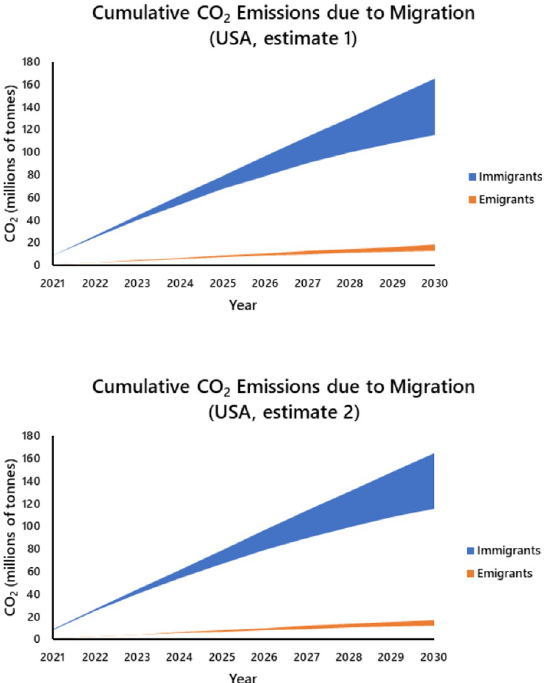
Fig 5. Projected annual cumulative CO 2 emissions associated with migration to and from the USA for the period 2021 to 2030. The upper limit of each curve assumes that the USA maintains 2005 emission levels, the lower limit assumes an annual reduction of 3% (= 30% reduction by 2030). Shading represents the range of possibilities for partial achievement of reduction targets. S1 Appendix provides a detailed explanation of the